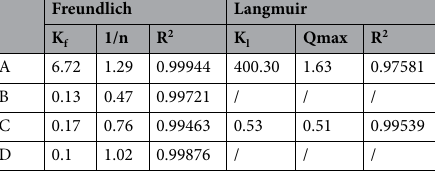
Table 5. Cu(II) isotherm adsorption model parameters for four groups of sediments from the mouth of Dianhu Lake.